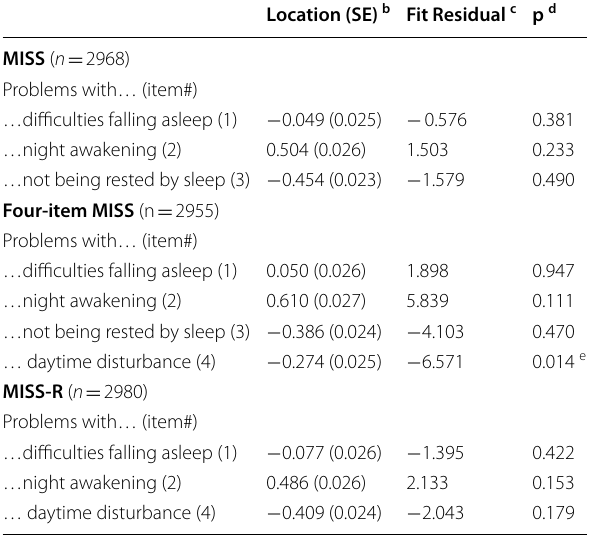
MISS Minimal Insomnia Symptom Scale, MISS-R MISS Revised, SE standard error a Based on data from respondents with no missing item responses (within each scale)